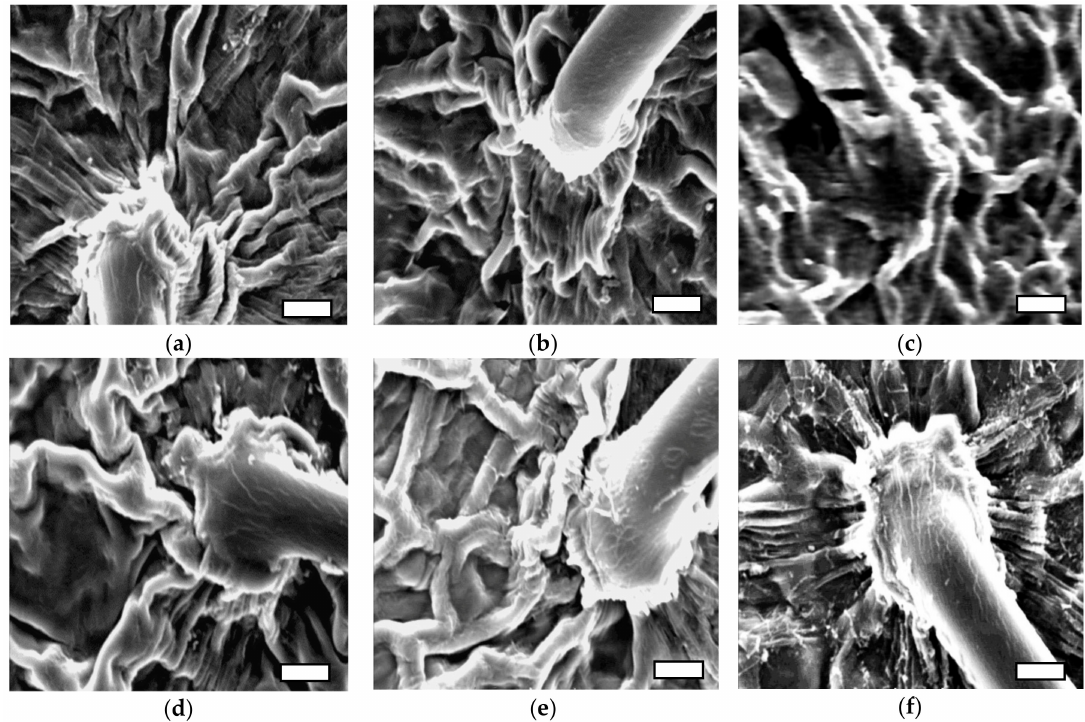
Figure 4. The e ff ects of salt stress and nSiO2 on the epidermal cell walls of strawberry leaves. (a) Cont; 0 mM NaCl + 0 mg L − 1 nSio2, (b) 0 mM NaCl + 100,50 mg L − 1 SiO2 (c) 25 mM NaCl + 0 mg L − 1 SiO2 (d) 25 mM NaCl + 100,50 mg L − 1 SiO2, (e) 50 mM NaCl + 0 mg L − 1 SiO2, (f) 50 mM NaCl + 100,50 mg L − 1 SiO2. Scanning electronmicroscope (SEM) image of the strawberry leaves. White scale bars = 20 µ